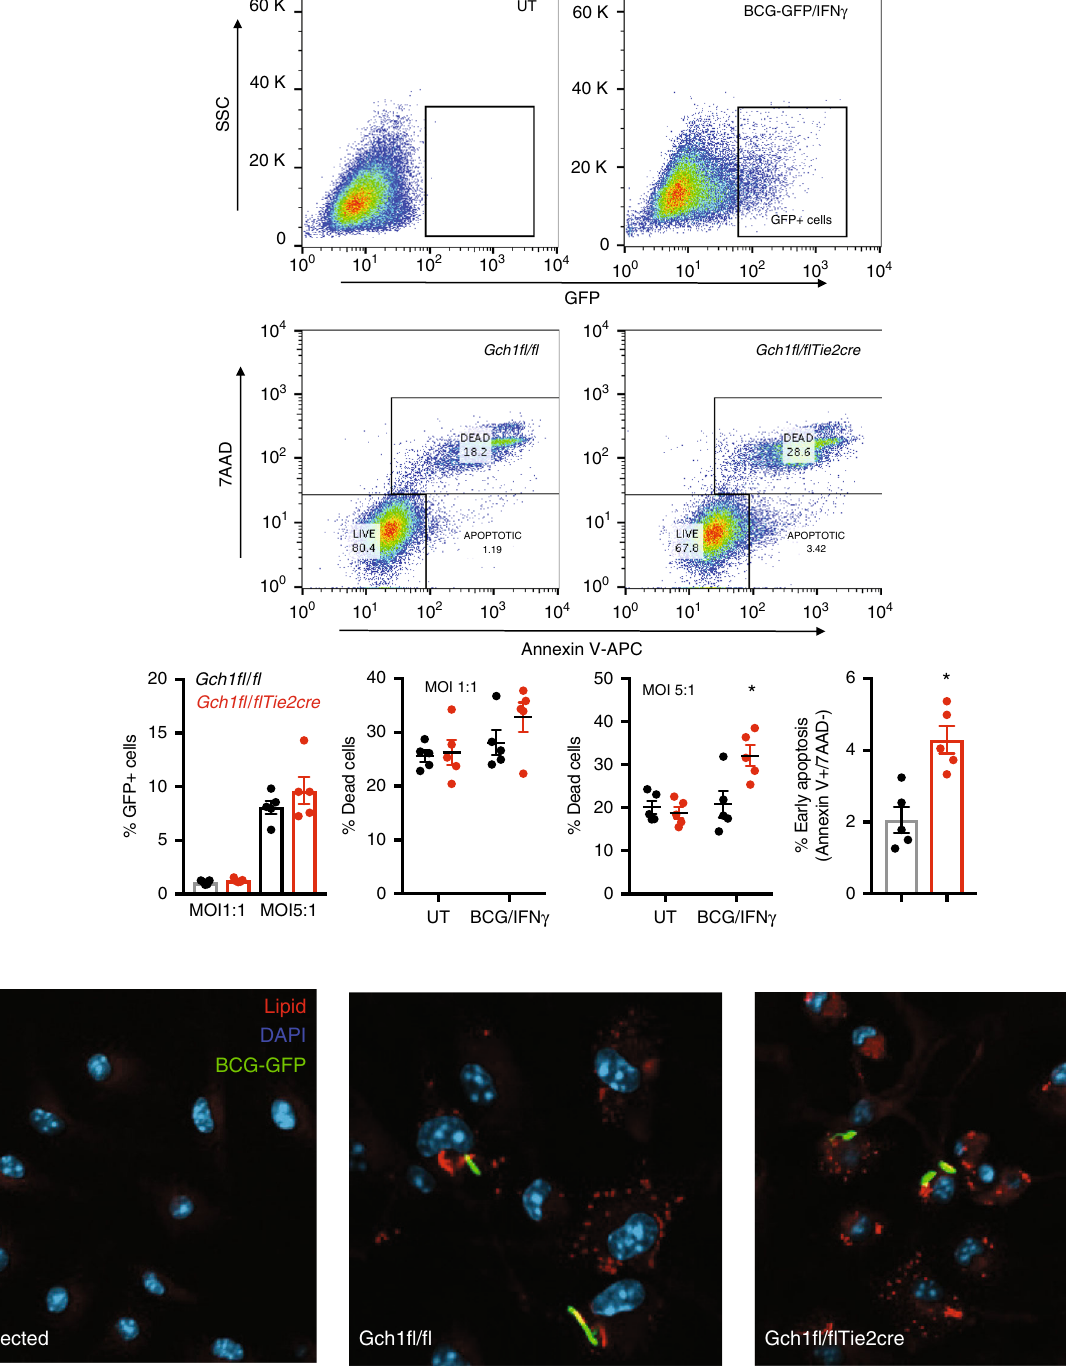
Fig. 9 BH4 de fi ciency alters infected cell viability. a Gch1 fl / fl Tie2cre and Gch1 fl / fl macrophages were stimulated IFN γ (10 ng/ml) and BCG (MOI 1:1 or 5:1) or left untreated overnight. At the end of the assay the cells were harvested and incubated in buffer containing 7AAD and Annexin V-APC for 15 min at room temperature. Staining was terminated by addition of buffer and cells were analysed by fl ow cytometry immediately. Cell death was de fi ned as Annexin V + /7AAD + . Infection was con fi rmed by detection of GFP and early apoptosis (Annexin V + /7AAD − ) was assessed in BCG-GFP + cells infected at MOI 5:1. Data was analysed by 2-way ANOVA * p < 0.05 with Bonferroni post-test or two-tailed t -test ( n = 5/genotype). b Gch1 fl / fl Tie2cre and Gch1 fl / fl macrophages were stimulated with IFN γ (10 ng/ml) and BCG (MOI 1:1) or left untreated overnight in the presence of 2% serum as a lipid source. At the end of the assay the cells were fi xed and neutral lipids were stained using LipidTox dye and nuclei stained with DAPI. Images are representative of 4 individual macrophage cultures. Error bars ±